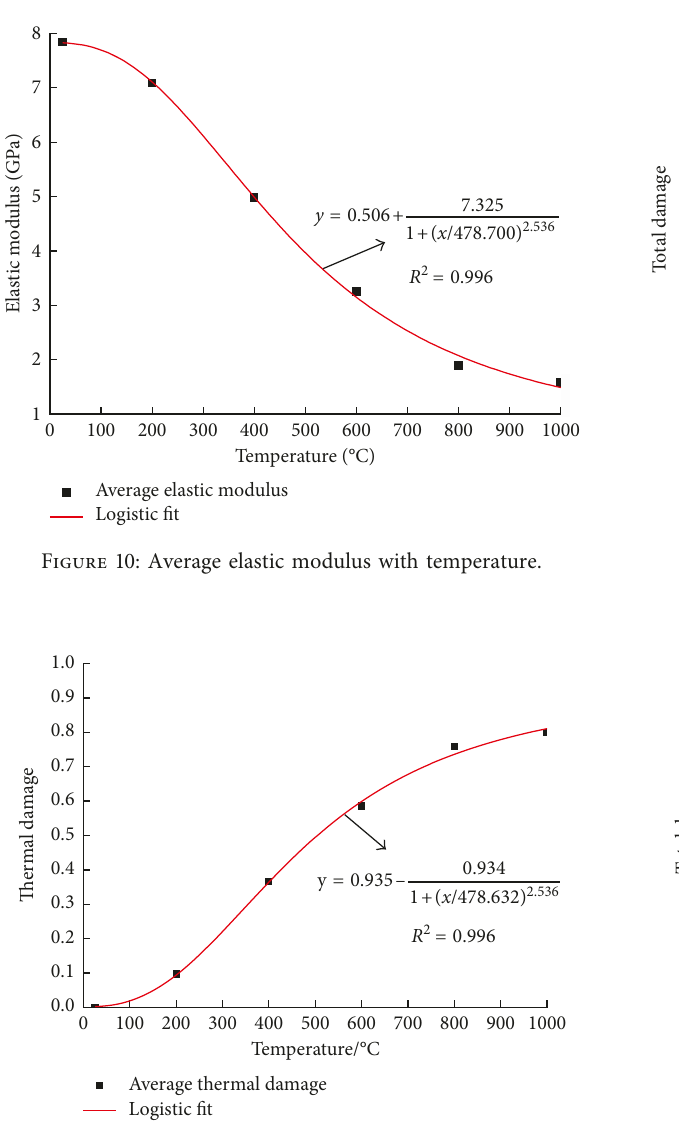
Figure 13: Total damage with